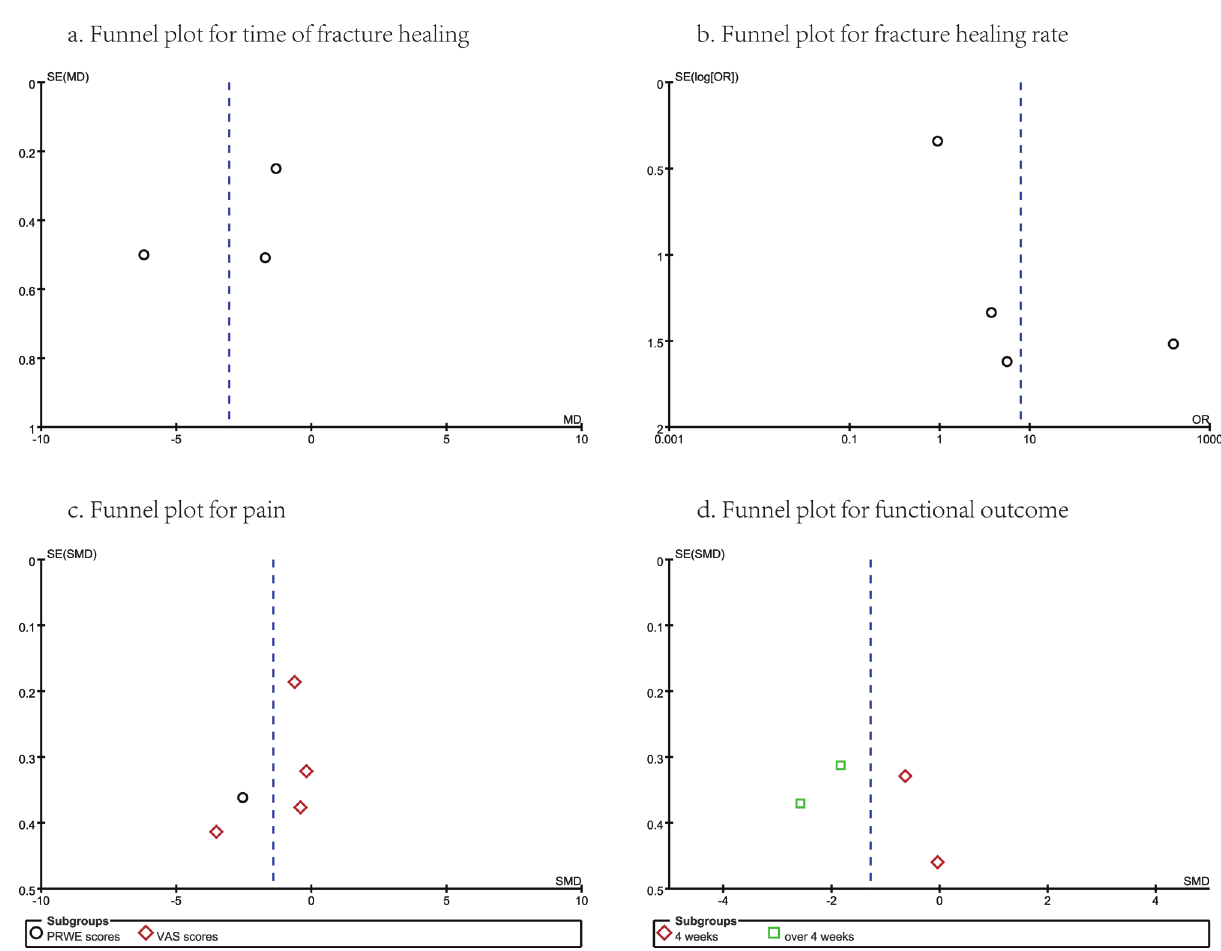
Figure 7 - Publication bias